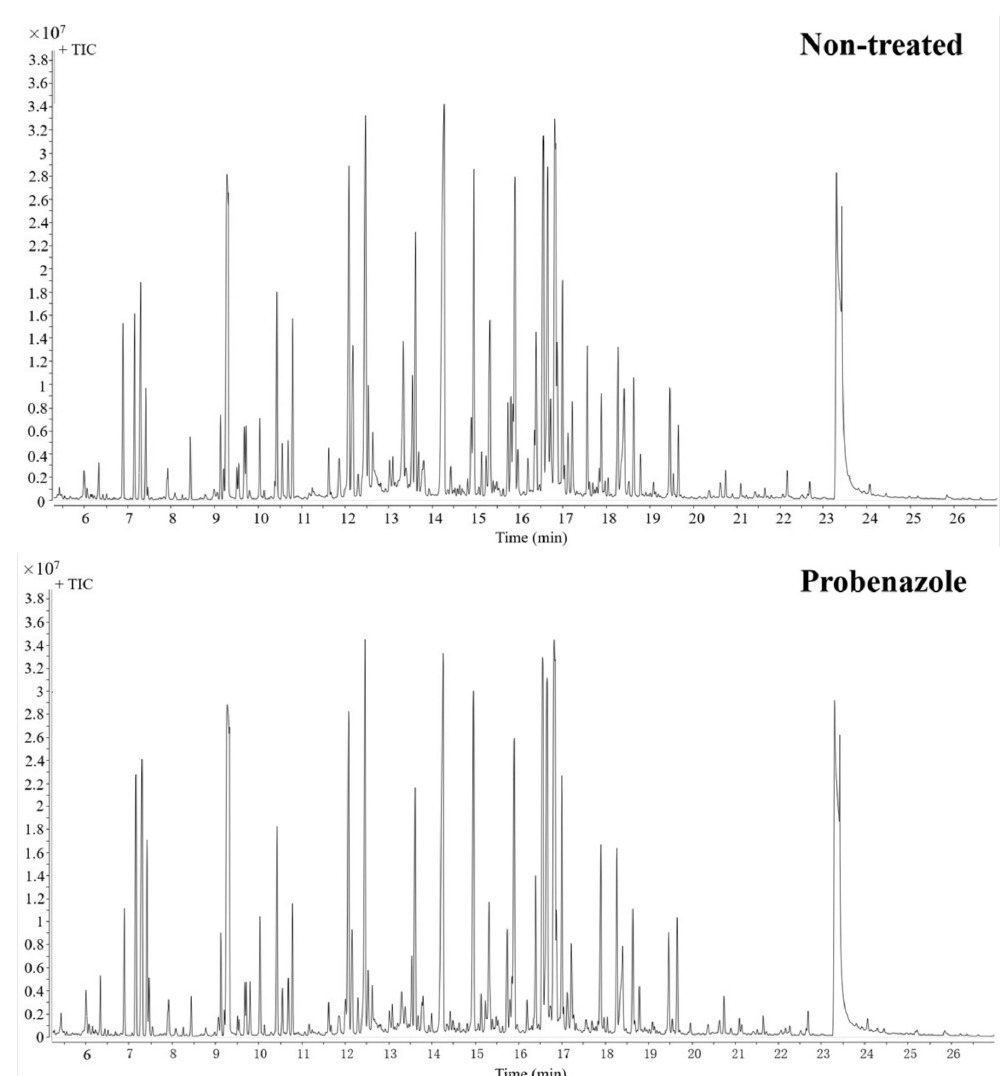
Figure 2. Total ion current diagram of gas chromatography–mass spectrometry on metabolites of rice seedlings either non-treated or treated with probenazole followed by inoculation with Magnaporthe grisea five days after the